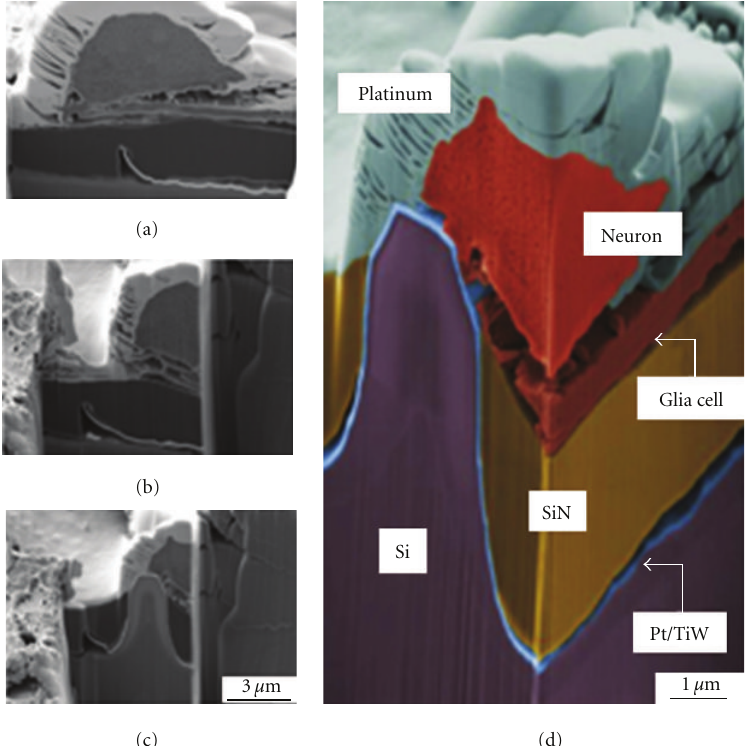
Figure 2: The unique pie-slice cutting method enables visualization of cocultivated primary murine glia cells and neurons on a microneedle array, reproduced with permission from